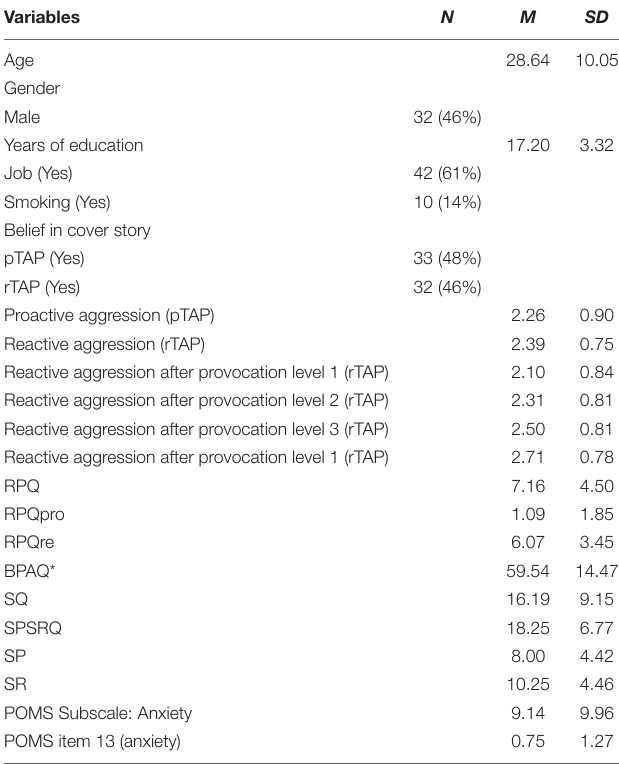
TABLE 1 | Descriptive statistics on the